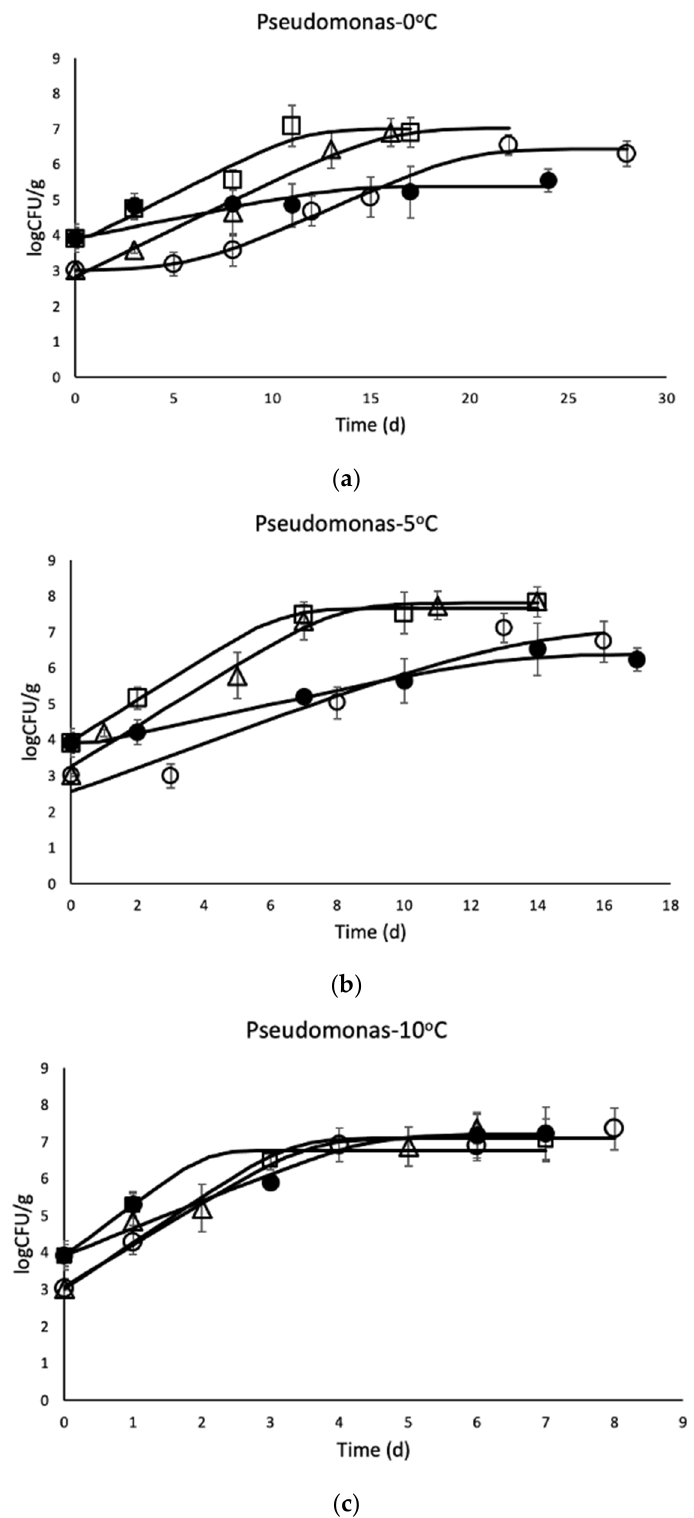
Figure 2. Enumeration of Pseudomonas spp. in chicken stored at ( a ) 0 °C, ( b ) 5 °C, and ( c ) 10 °C ( (cid:1) xontrol, ● MAP, ○ EC-flav, △ EC-glu).